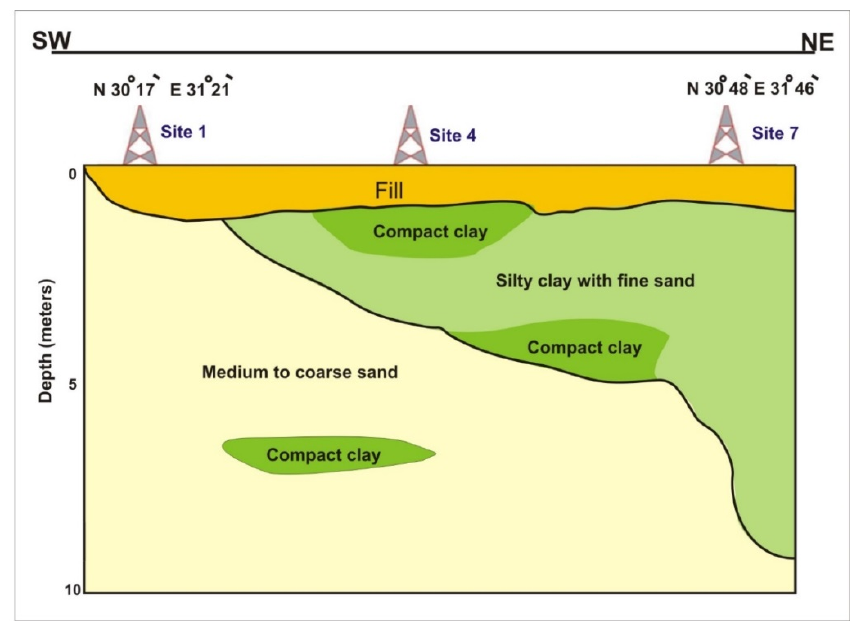
Figure 5. Geological cross section showing the soil profile along the study sited based on drilled boreholes at sites 1, 4, and 7 (for location, see Figure 1) .